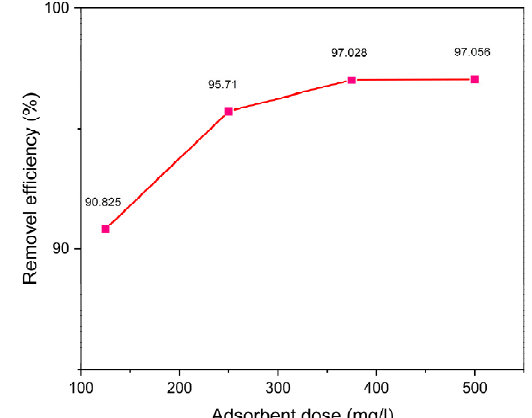
Fig. 12. Effect of adsorbent dose on the removal efficiency of Pb(II) by nanoparticles.